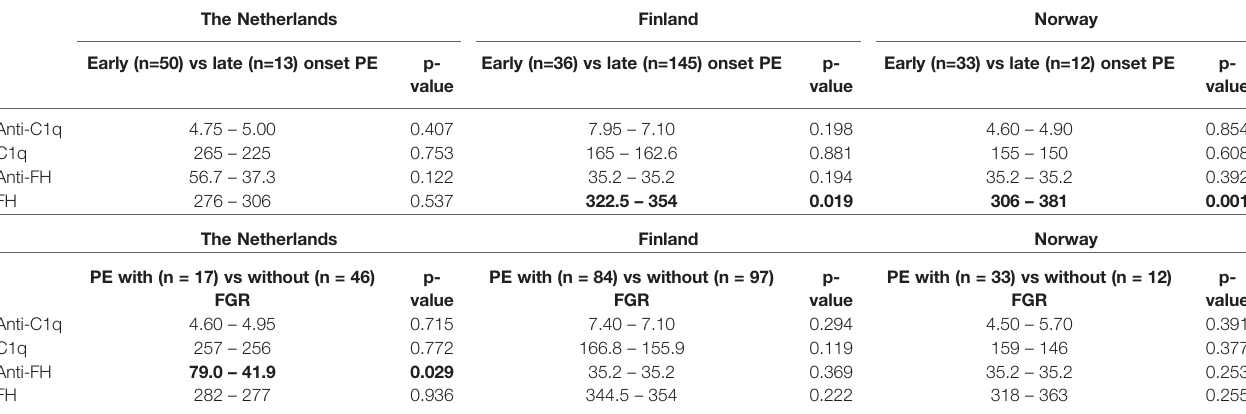
TABLE 4 | Analysis of complement factors C1q, FH and autoantibodies in subgroups based on early onset of disease or presence of fetal growth restriction. The Netherlands Finland Norway Early (n=50) vs late (n=13) onset